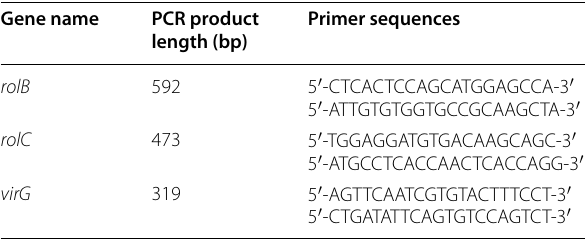
Table 1 The sequences of primers used to determination of transgenic